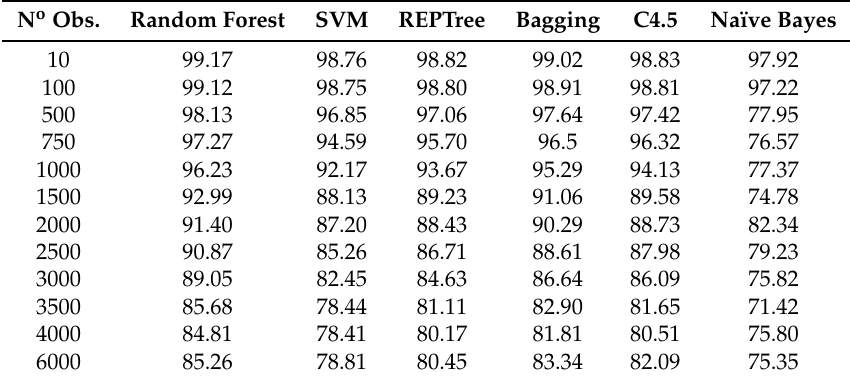
Table 2. Classification accuracy (%) for action pruning. N o Obs.